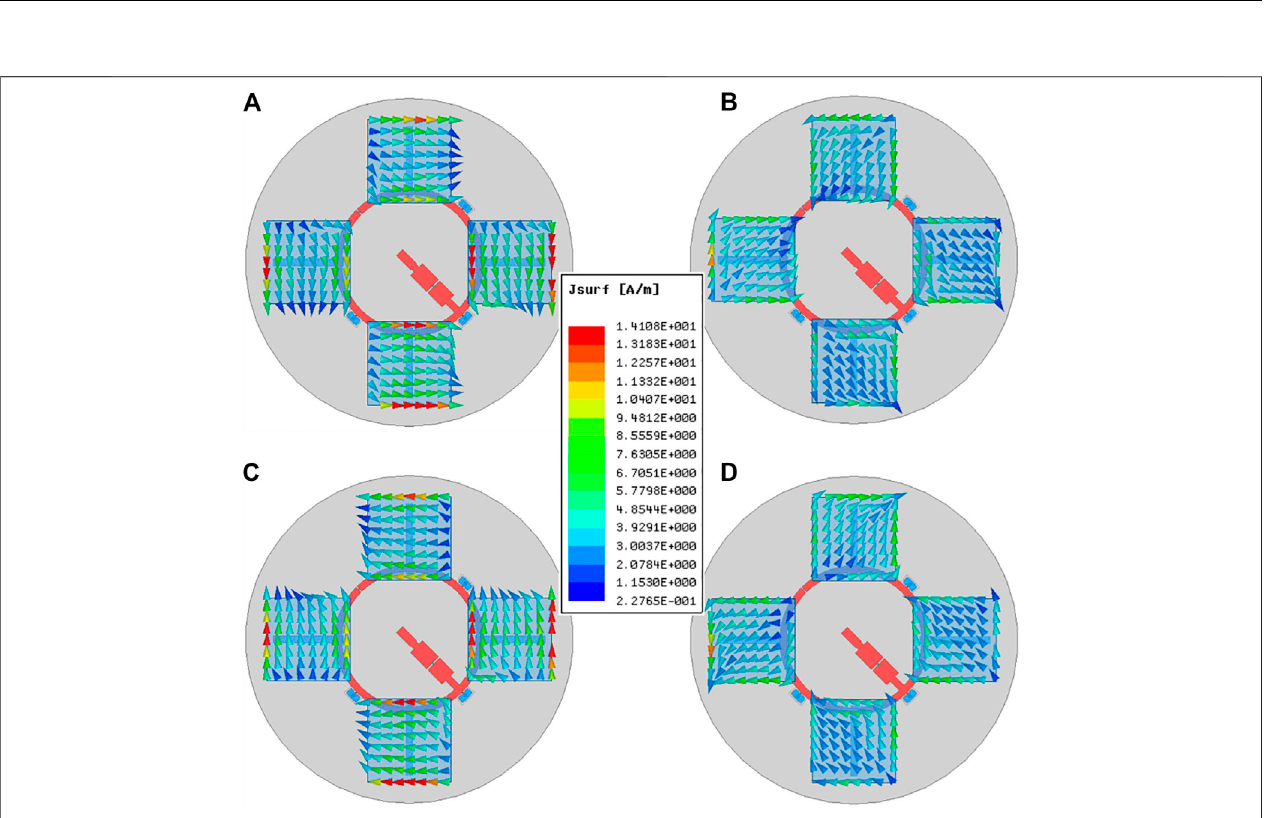
FIGURE 4 | Simulated current distributions on the patches over a period of time when both SW1 and SW2 are ON: (A) t (cid:1) 0; (B) t (cid:1) T/4; (C) t (cid:1) T/2; (D) t (cid:1) 3T/4.